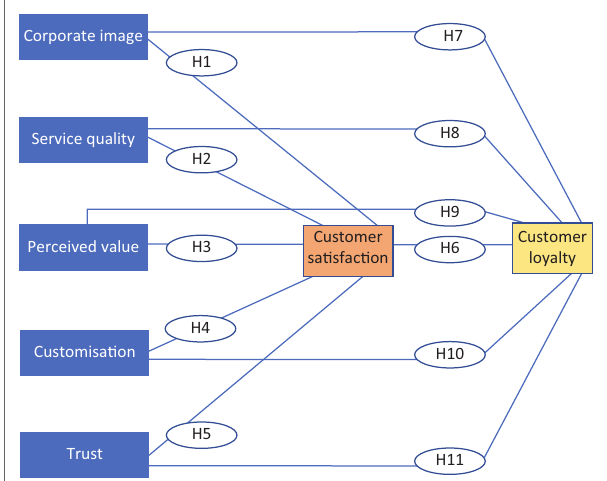
FIGURE 1: Proposed theoretical